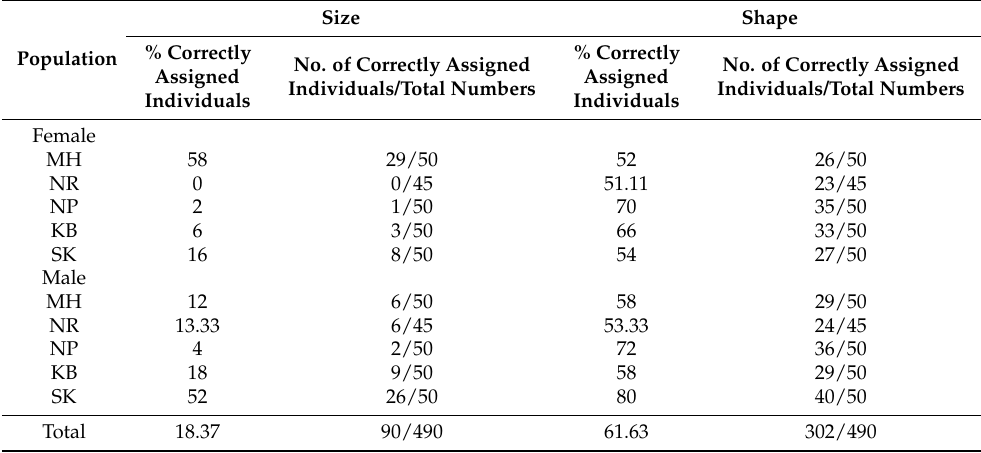
Figure 7. Hierarchical clustering tree based on Mahalanobis distances of female and male S. calcitrans populations. Numbers at the nodes indicate the percentages of bootstrap values based on 1000 bootstraps. Table 4. Percentage of correctly assigned individuals based on the cross-validated classification of the wing size and shape of female and male S. calcitrans populations.